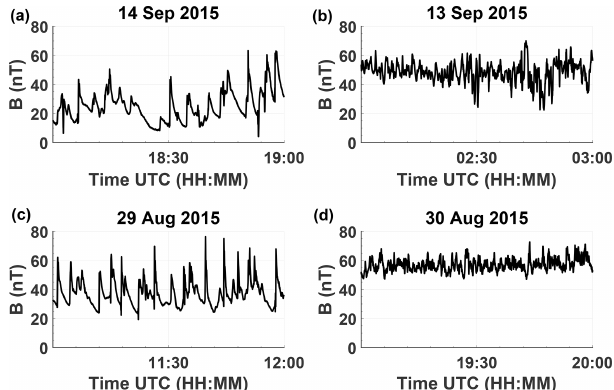
Figure 5. In (a) and (c) , typical examples of an interaction region dominated by large-amplitude steepened waves are shown. In (b) and (d) , the interaction region 1d later or earlier is shown. Instead of large-amplitude steepened waves, oscillations on smaller scales and with significantly smaller amplitude are visible, which resemble 1P/Halley’s interaction region (Glassmeier et al., 1997). The illus- trated time intervals correspond to the highlighted peaks in detec- tion time in Fig.